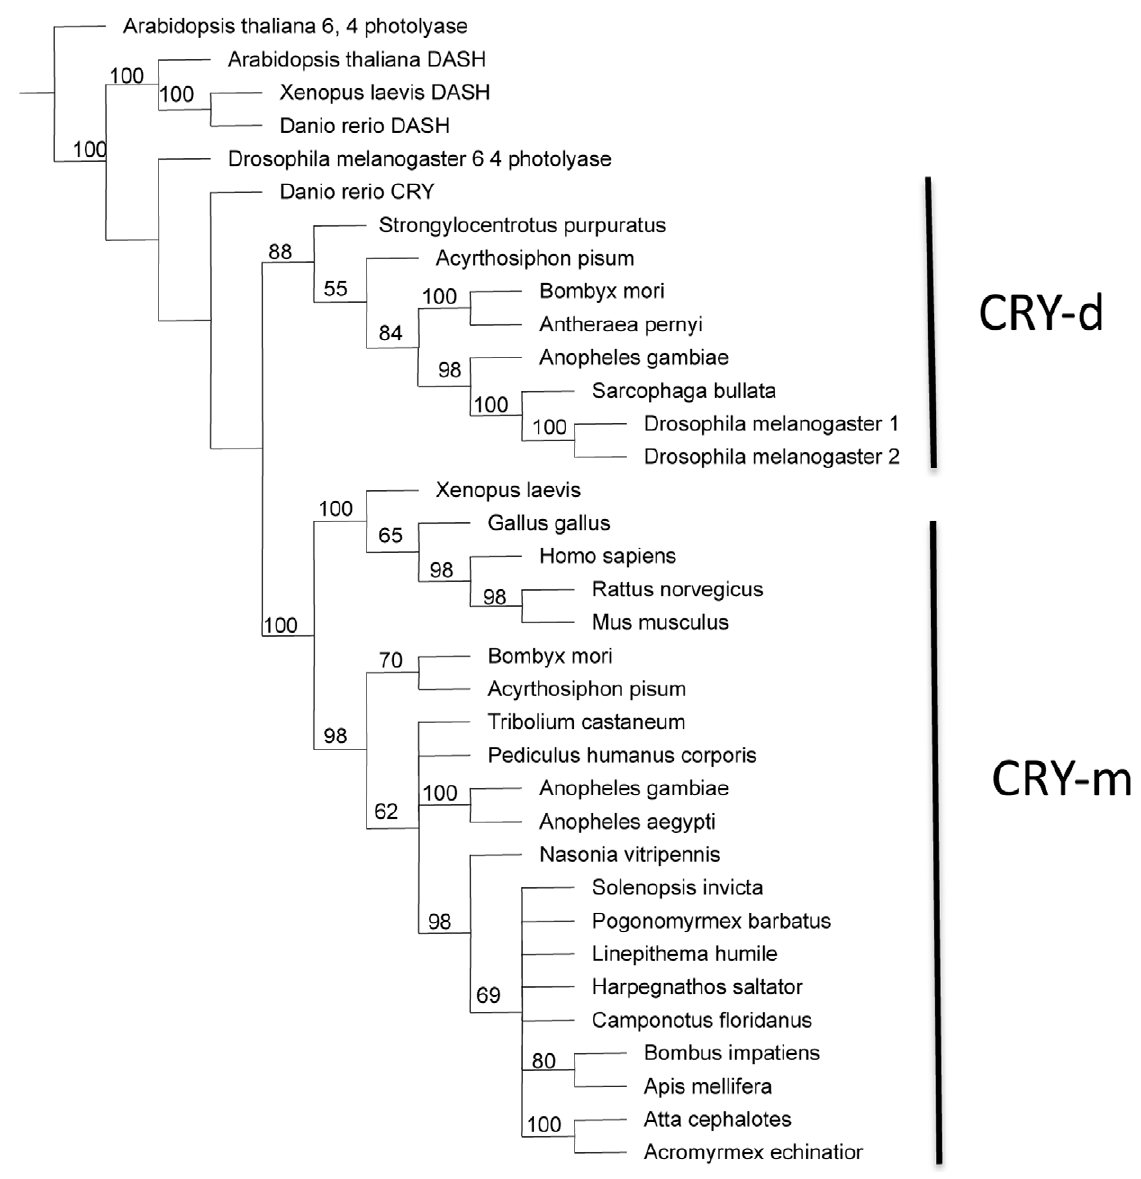
Figure 1. Parsimony tree for cryptochrome gene family. Shown is a consensus tree with bootstrap values from 250 replicates. Outgroups include orthologs of photolyase and DASH. Cryptochromes segregate into two clades, Drosophila -like (CRY-d, also known as "insect CRY1") proteins and mammalian-like (CRY-m, also known as "insect CRY2") proteins. CRY-d proteins are light sensitive with no transcriptive repressive activity whereas CRY-m proteins are light insensitive and may function as the main transcriptional repressors of the core clockwork [1]. All of the Hymenopterans (bees, ants, and wasps) have only the Cry-m genes. doi:10.1371/journal.pone.0045715.g001 present in Hairy and class b basic helix-loop-helix proteins (data not shown).